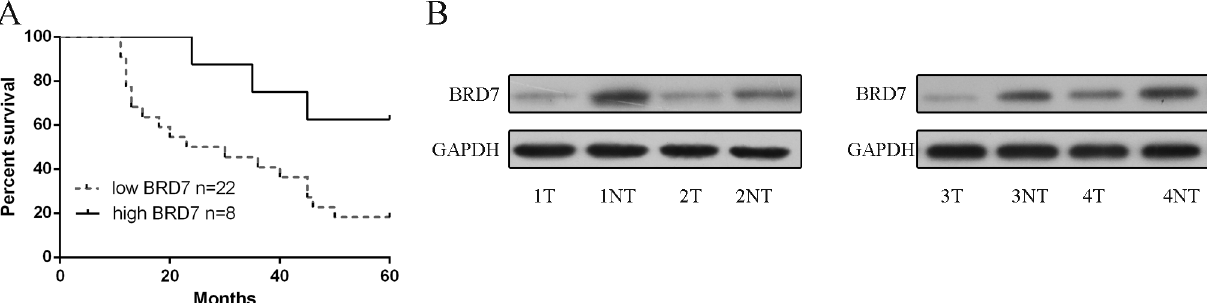
Fig 3. The protein expression level of BRD7 was downregulated in lung adenocarcinoma tissues. (A) Lower of BRD7 levels in patients with lung adenocarcinoma was associated with shortened disease-free survival (hazards ratio = 0.36). (B) The protein expression level of BRD7 was measured in lung adenocarcinoma tissues and their corresponding adjacent normal tissues using Western